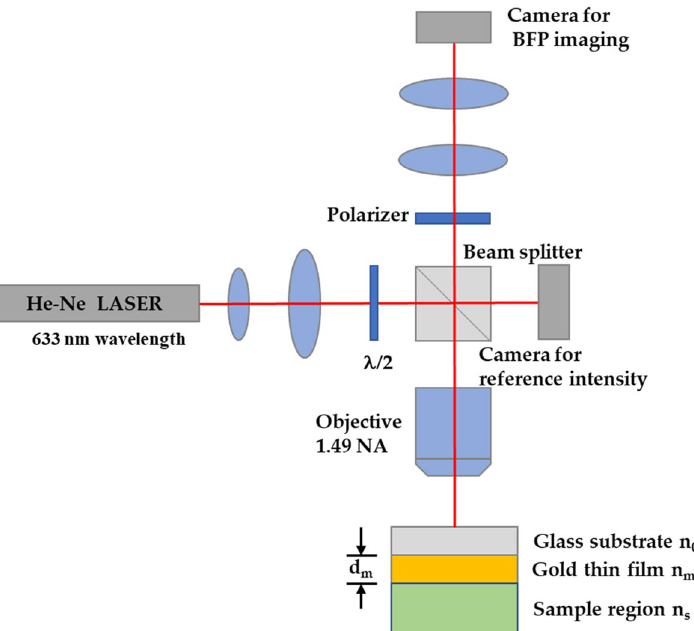
Figure 2. Modified optical microscope for SPR phase imaging.